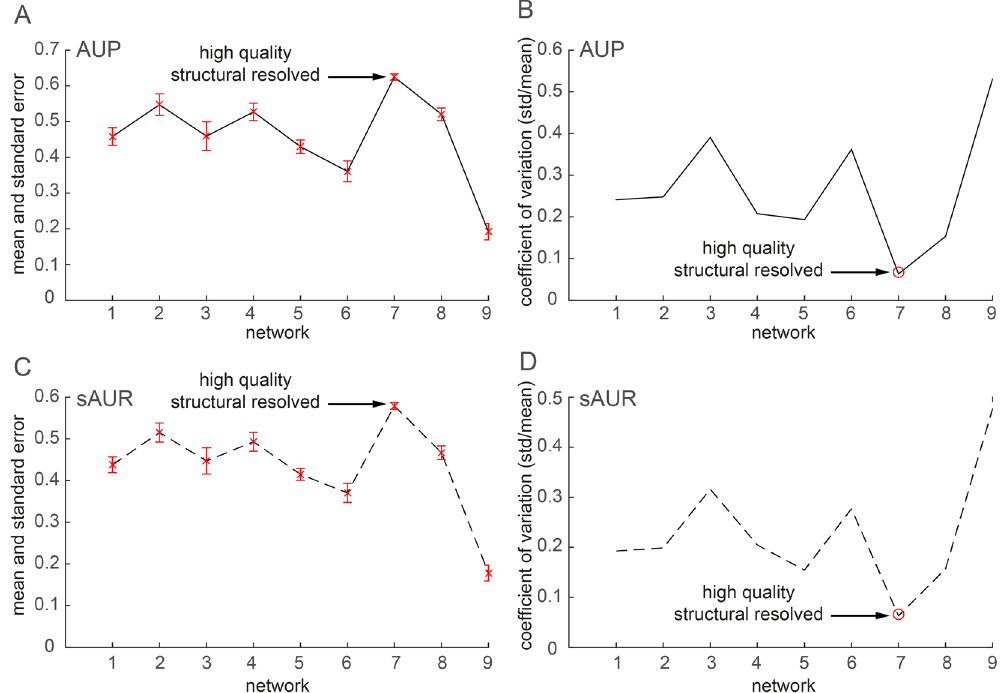
Figure 6. New GO-based evaluation framework. ( A ) Mean AUP values (y-axis, computed as average of all the methods for each network) and standard errors (red bars) for each network (x-axis). ( B) Coefficient of variation (y-axis) of the AUP values for each network (x-axis). ( C) Mean sAUR values and standard error for each network. ( D) Coefficient of variation of the sAUR values for each